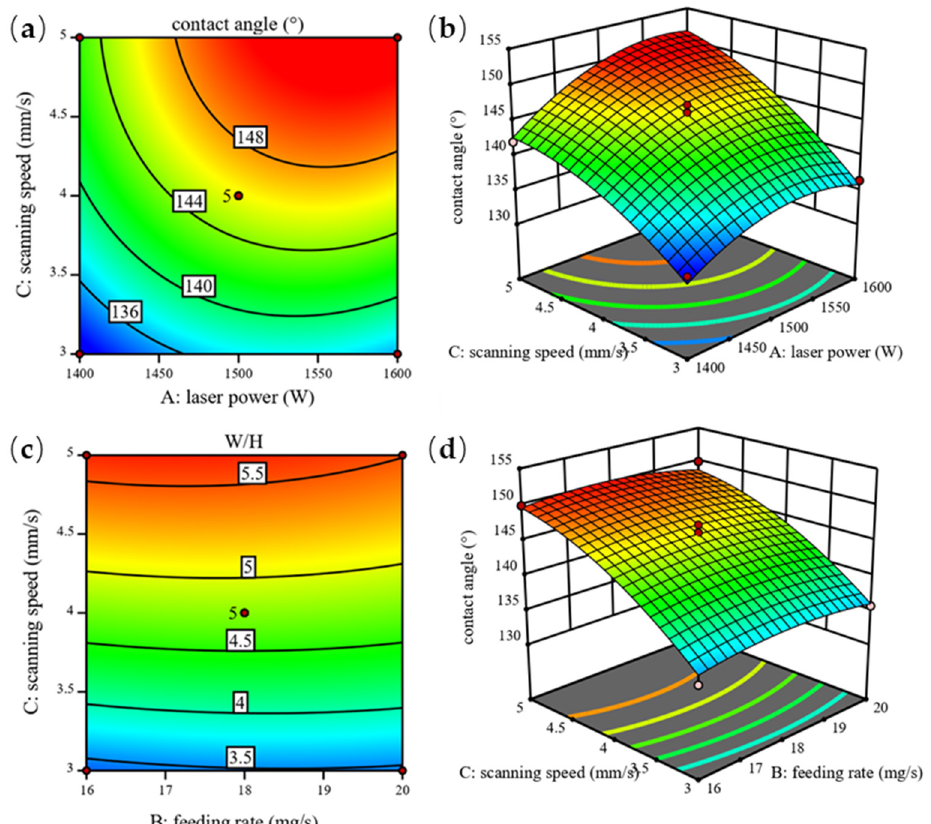
Figure 11. Contour lines for the effects of the interactions of ( a ) the laser power and scanning speed and ( c ) the powder feeding rate and scanning speed on the contact angle. Impact of the correlation between ( b ) the laser power and scanning speed and ( d ) the powder feeding rate and scanning speed on the response surface of the contact angle.